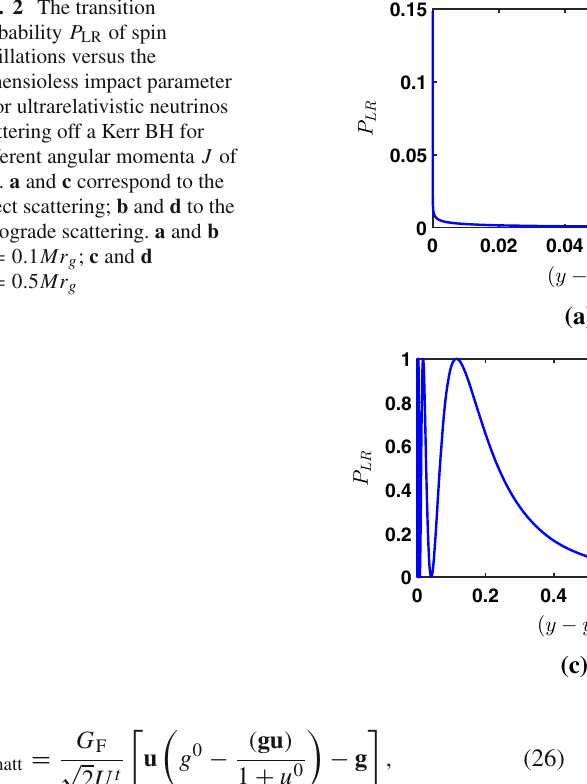
Fig. 2 The transition probability P LR of spin oscillations versus the dimensioless impact parameter y for ultrarelativistic neutrinos scattering off a Kerr BH for different angular momenta J of BH. a and c correspond to the direct scattering; b and d to the retrograde scattering. a and b J = 0 . 1 Mr g ; c and d J = 0 . 5 Mr g